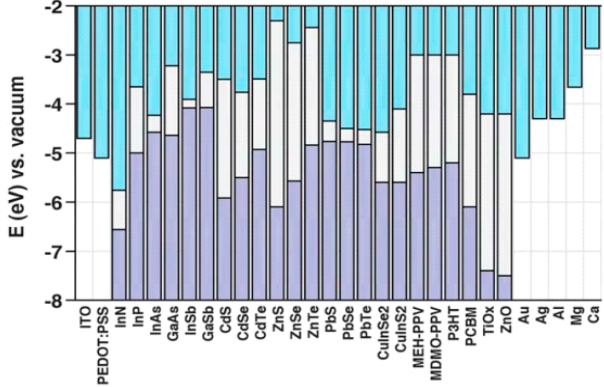
Figure 15. The energy levels of various materials used in hybrid solar cells, where the grey region corresponds to the electronic band gap present in such materials. Reproduced from [37] with permission of the Royal Society of Chemistry.